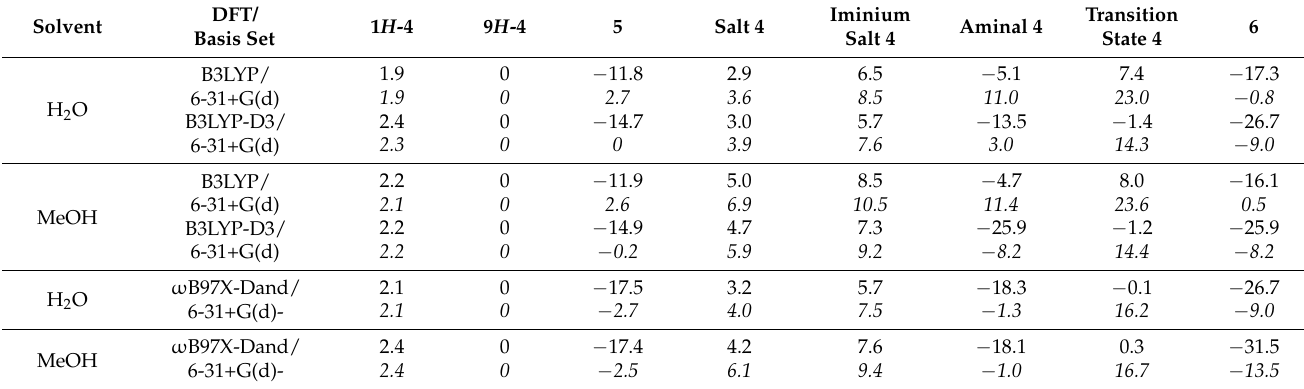
Table 3. The relative electronic (plain text) and Gibbs free (italics) energies (kcal/mol) of subsequent stages of the tandem Mannich—electrophilic amination reaction calculated by DFT/PCM methods. DFT/ Solvent 1 H Basis Set